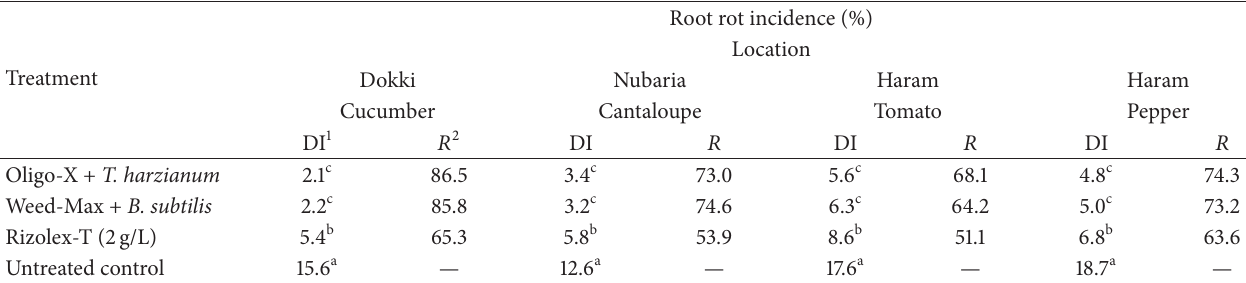
Table 3: Application of algae compounds and bioagent formula against root rot disease of cucumber grown in plastic houses under protected cultivation system at different locations.